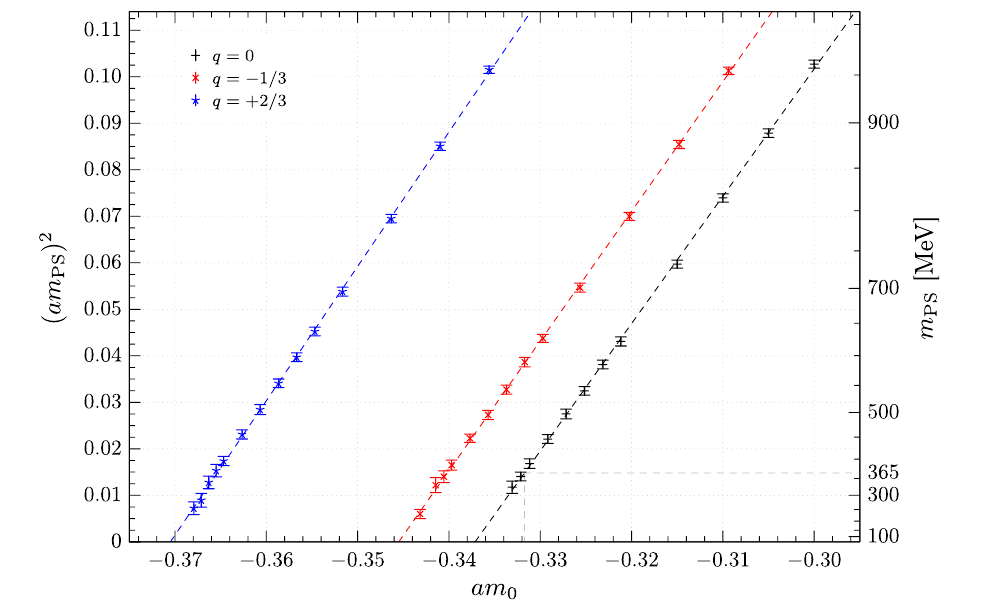
Fig. 5 Mass of the ¯ Q (cid:15) γ 5 Q valence pseudoscalar neutral meson has been calculated as a function of q and am 0 = 1 /( 2 κ) − 4. QCD + qQED setup: SU(3) configurations are taken from the QCD1 ensemble (Table 1) and pure U(1) configurations are generated with α 0 = 0 . 05 and q el = 1 / 6. The dashed curves are fits to the expected (leading